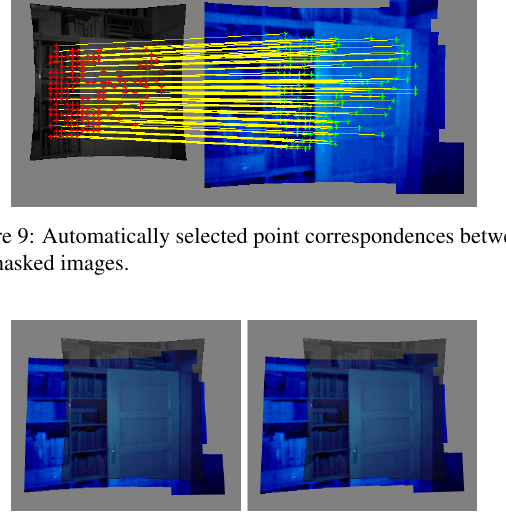
Figure 10: Passive intensity image and transformed IR image for manual determination of point correspondences (left) and auto- matic determination (right).